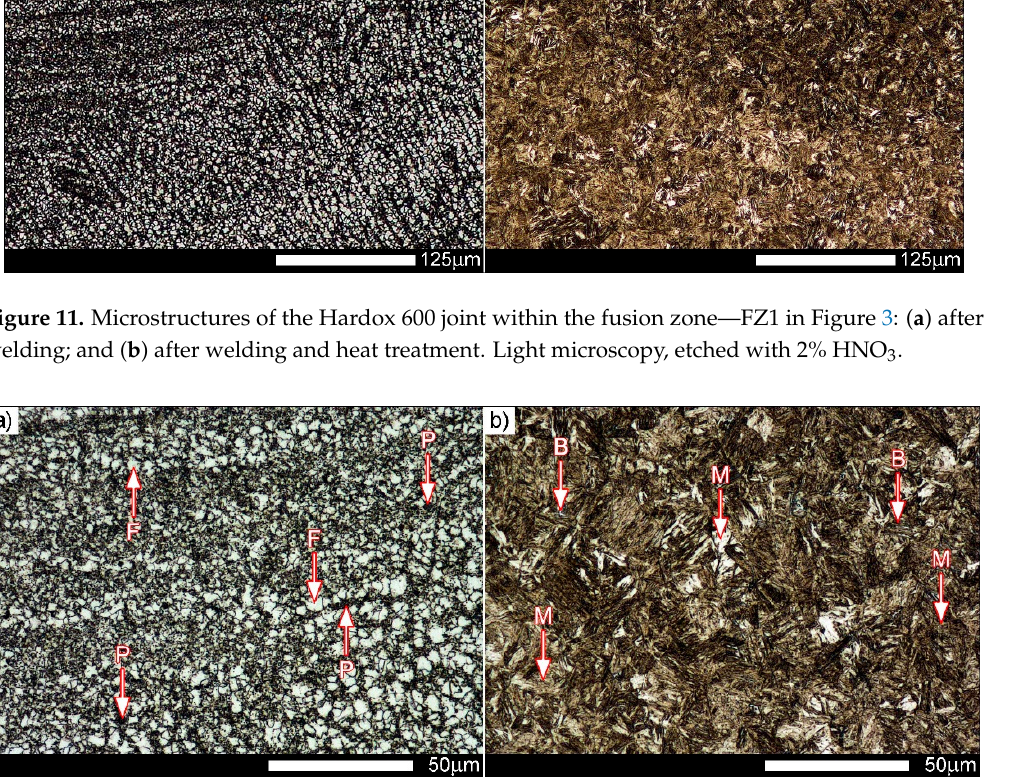
Figure 12. Magnified images of the microstructures shown in Figure 11 (fusion zone FZ1): ( a ) after welding; and ( b ) after heat treatment. B—bainite, F—ferrite, M—martensite, P—pearlite. Light microscopy, etched with 2% HNO 3 .